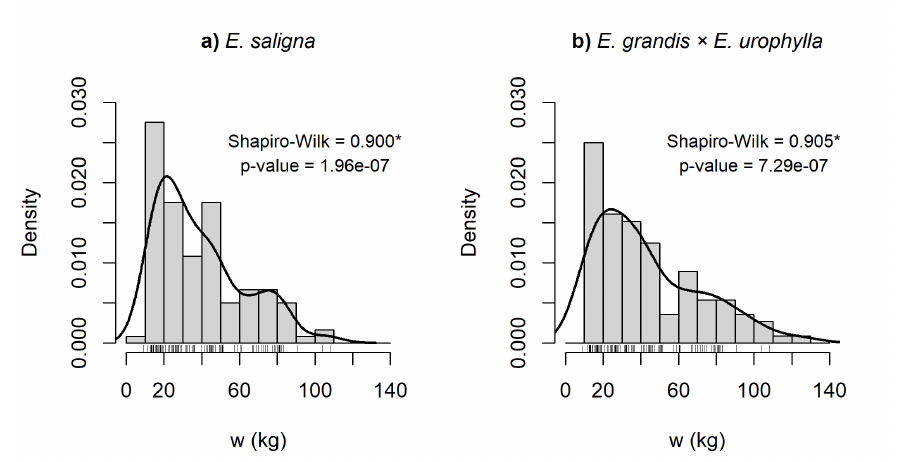
Figure 1 - Residual biomass distribution (w) of wood harvesting in E. saligna ( a ) and E. grandis × E. urophylla ( b ) stands.